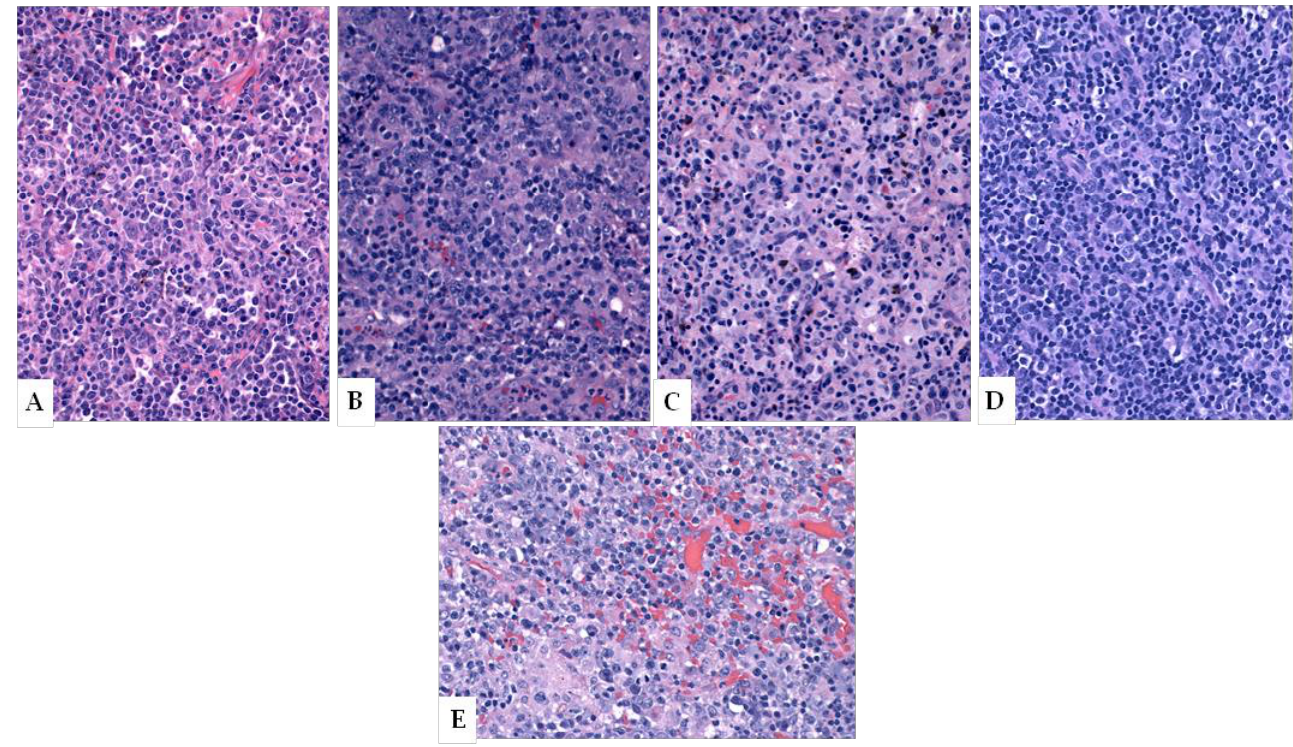
Figure 6. The WHO-HAEM5 recognizes that polymorphic lymphoproliferative disorders, lesions that are composed of a heterogeneous cell population, can occur in a variety of immunodeficiency settings, including ( A ) post-transplant, ( B ) iatrogenic, ( C ) HIV infection, ( D ) inborn errors of immunity, and ( E ) post-chemotherapy (hematoxylin and eosin, 20× original magnification).